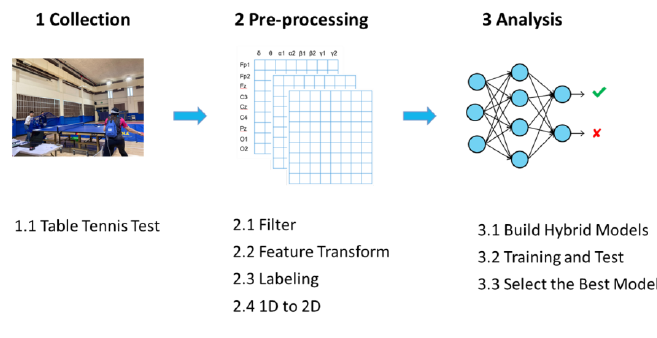
Figure 1. Research flow